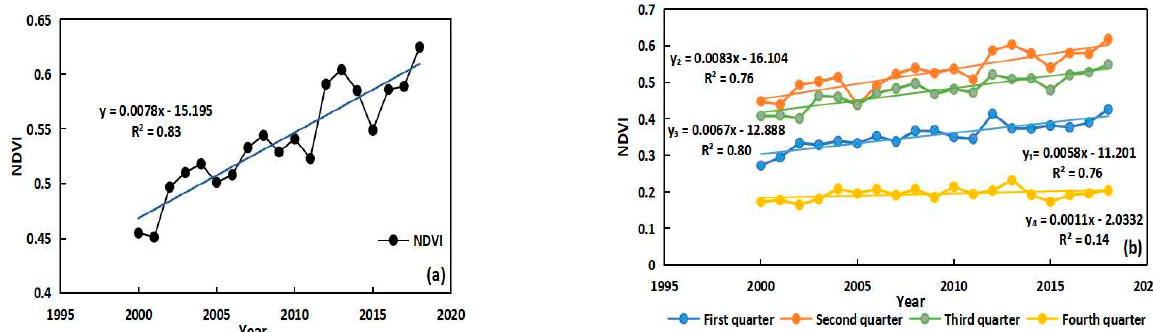
Figure 5. Spatial average trends of ( a ) annual NDVI and ( b ) quarterly NDVI scales during 2000–2018.